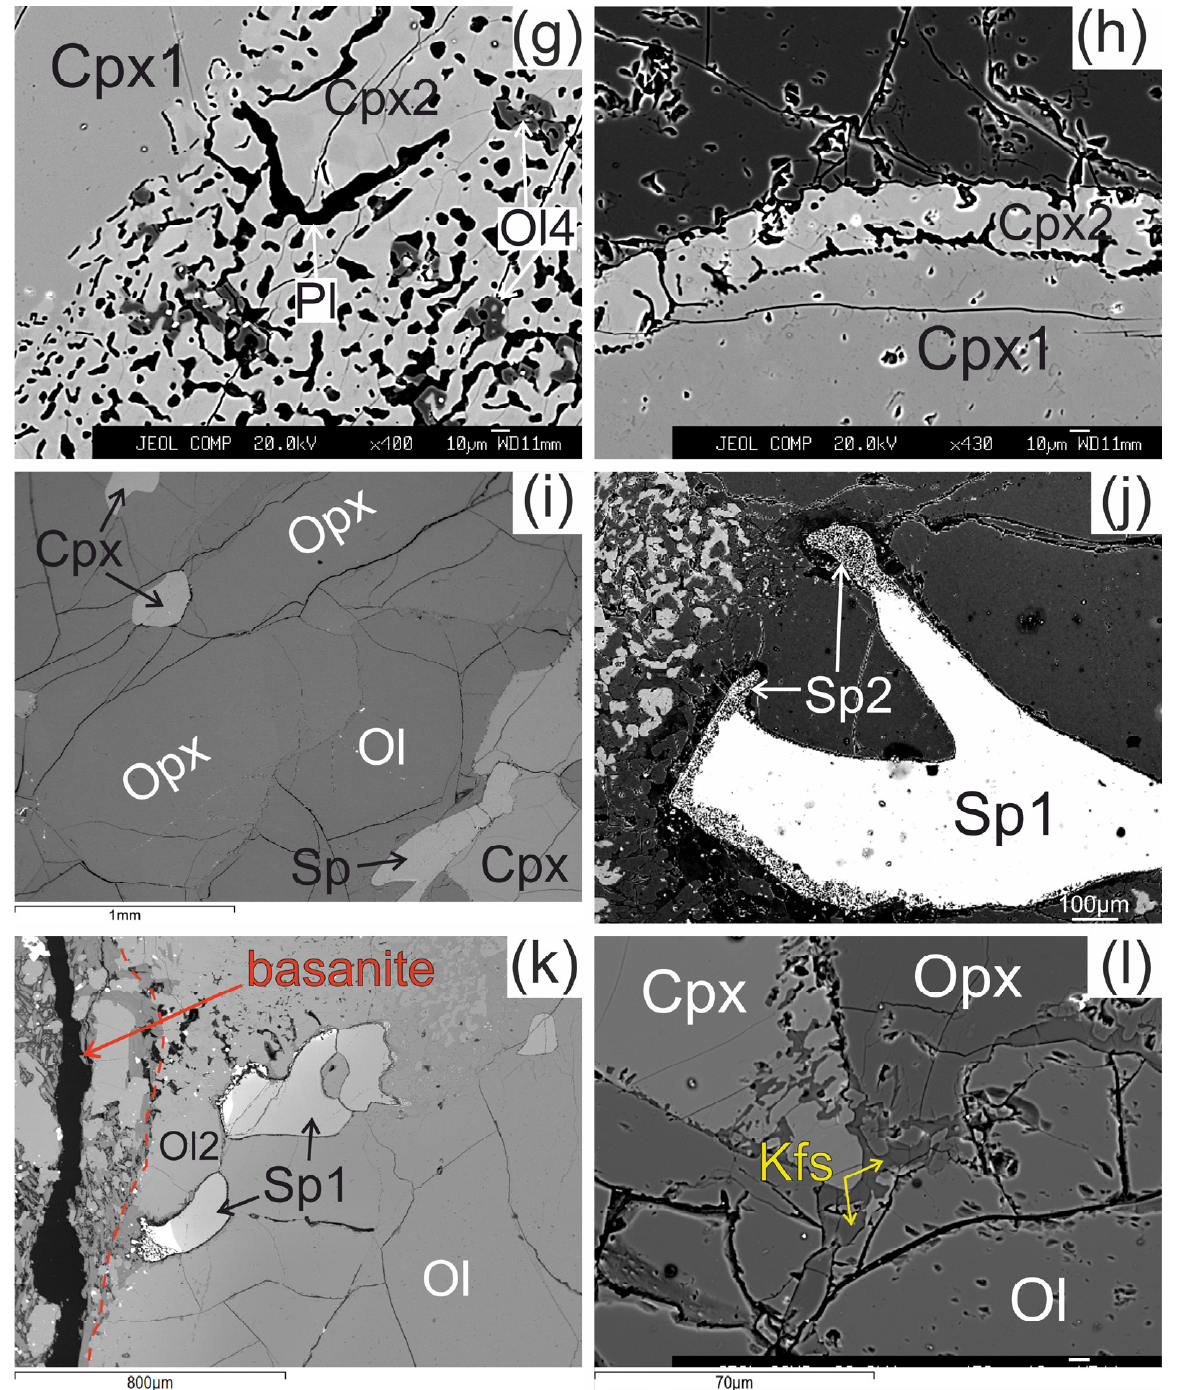
Figure 2. Microstructural features of lherzolite xenolith of Tumusun volcano (back-scattered electron images). ( a ) Development of Ol2 rim after Ol1 at basanite/xenolith contact. Opx has wide reaction zone. Cpx has wider reaction zones on the grain boundaries oriented towards the contact. ( b ) Grain of orthopyroxene located close to basanite/xenolith contact and composed of non-reacted Opx1 and orthopyroxene reaction zone represented by secondary olivine (Ol3), clinopyroxene (Cpx3), and alkali feldspar (Kfs). The yellow dashed line shows the border of former orthopyroxene grain. Spinel (Sp1) has reaction zones at the contact with orthopyroxene. Clinopyroxene (Cpx1) has a reaction zone of different width. The areas within the two rectangles are shown at higher magnification in the Figure 2g,j, respectively. ( c ) Orthopyroxene reaction zone of second type, lo ‐ cated at distance of 2 mm from the basanite/xenolith contact. Unreacted Opx1 is surrounded by secondary Opx2 intergrown with vermicular Kfs. These aggregates are cut by a chain of secondary Ol3. A smaller part of the reaction zone is made of Ol3, Cpx3, and Kfs. ( d ) Orthopyroxene grain with a thin reaction zone located at some distance from basanite/xenolith contact. ( e ) Zoned reac ‐ tion zone (Ol3+Cpx3+Pl) irregularly developed around orthopyroxene inside xenolith. ( f ) Reaction zone of orthopyroxene (Ol3+Kfs) without secondary clinopyroxene, and reaction zone of spinel in ‐ side xenolith. ( g ) Detailed image of clinopyroxene reaction zone composed of Cpx2 with inclusions of Ol4 (grey) and plagioclase (Pl, black) from Figure 2b. ( h ) Detailed image of clinopyroxene reac ‐ tion zone from Figure 2f. ( i ) The center of large xenolith without reaction zones of pyroxenes and spinel. ( j ) Detailed image of spinel reaction zone from Figure 1b. The spinel reaction zone is com ‐